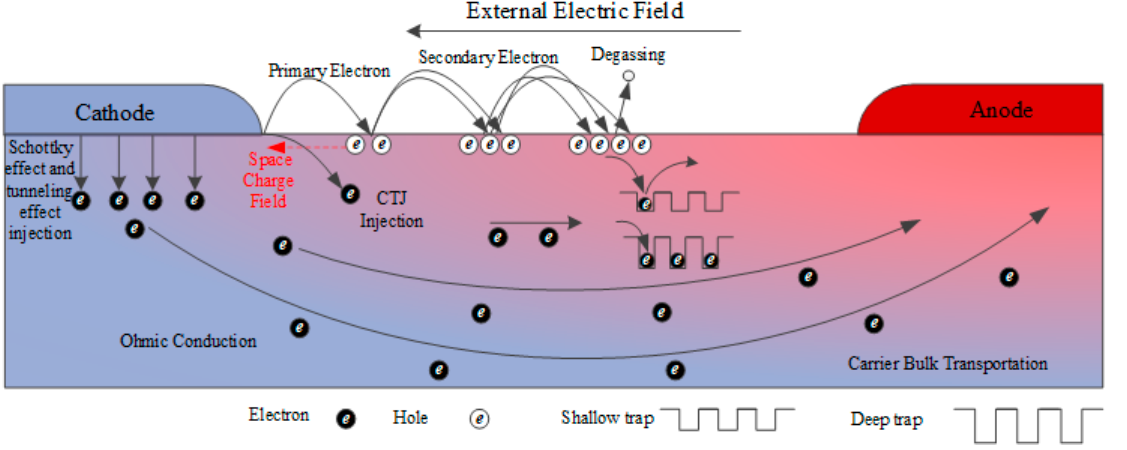
Figure 14. Bilayer model for the development of vacuum DC surface flashover.